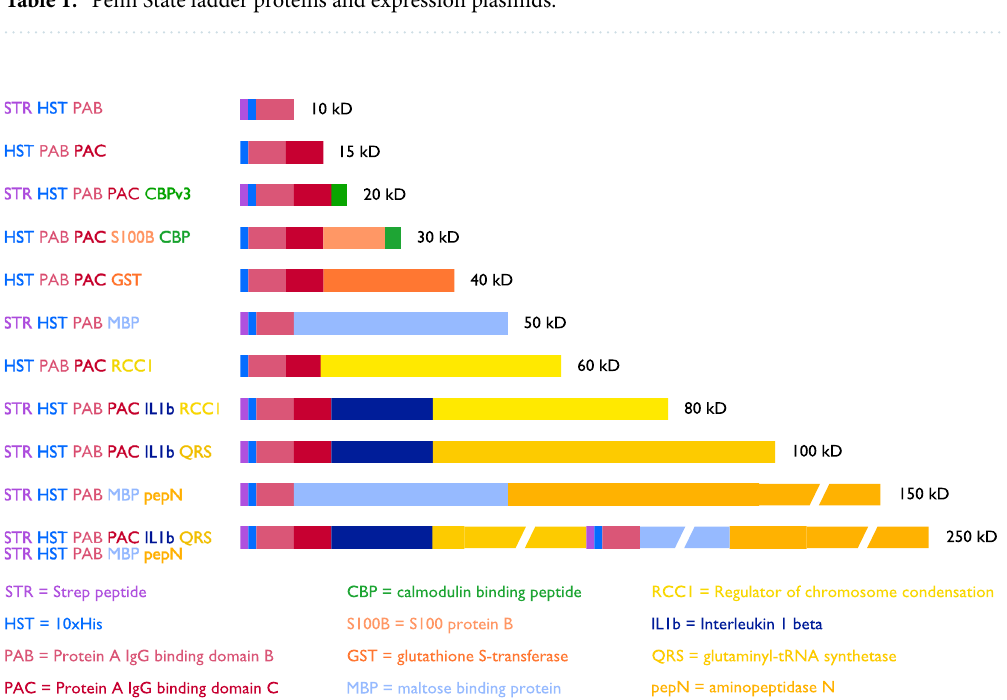
Table 1. Penn State ladder proteins and expression plasmids.